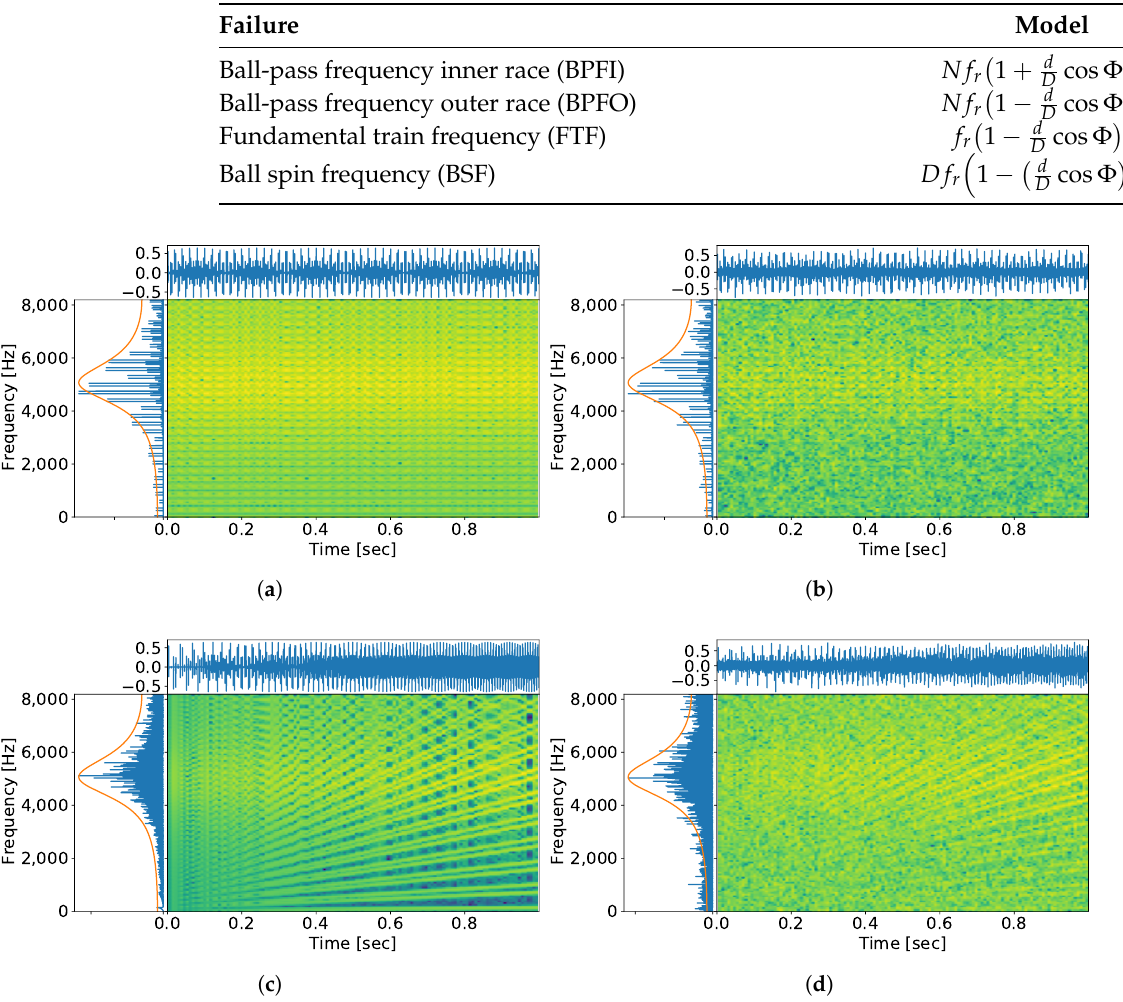
Table 2. Adjusted frequencies of rolling-element-bearing (REB) failures. Note: f r , instantaneous angular speed (IAS); d , REB diameter; D , pitch circle diameter; N , number of REBs; and Φ , con- tact angle.